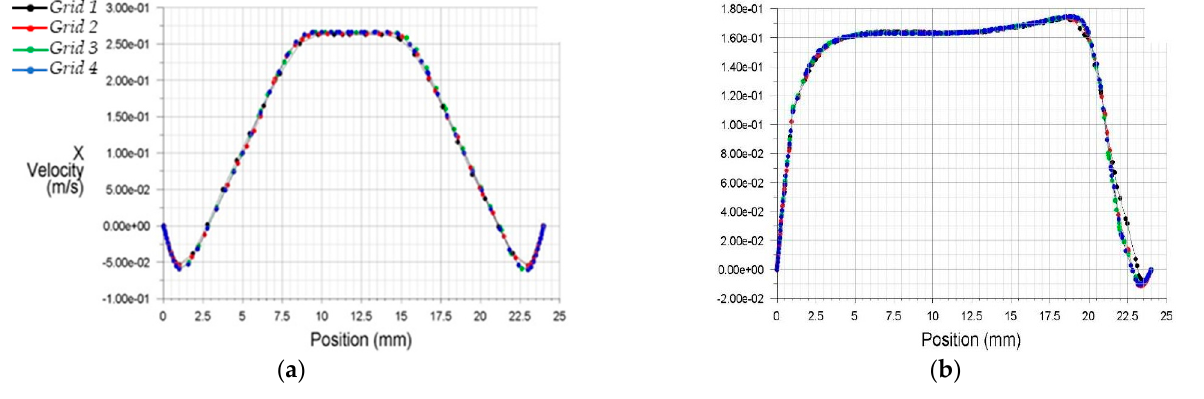
Figure 5. Streamwise x velocity profiles at two downstream stations from the stenosis ( a ) 0.5D, ( b )